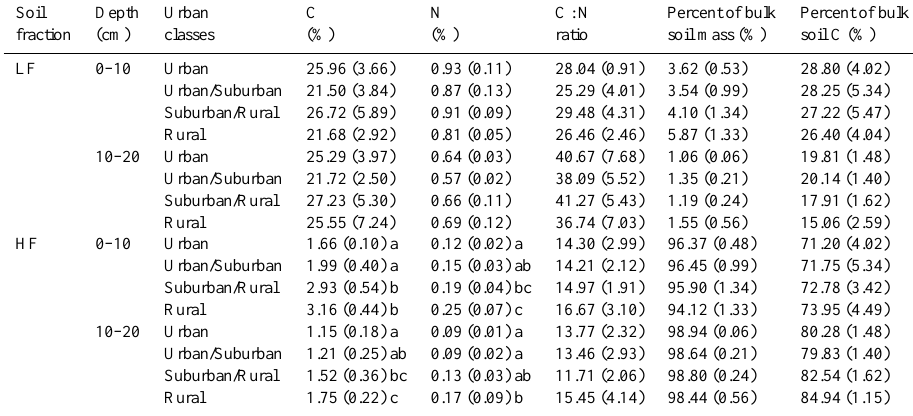
The different letters indicate significant differences at P <0.05 level, and no letters indicate no significant differences between different urbanization gradient classes, respectively (SNK test). Values are means with S. E. in parentheses ( N = 3 for urban and rural, N = 4 for urban/suburban and suburban/rural).